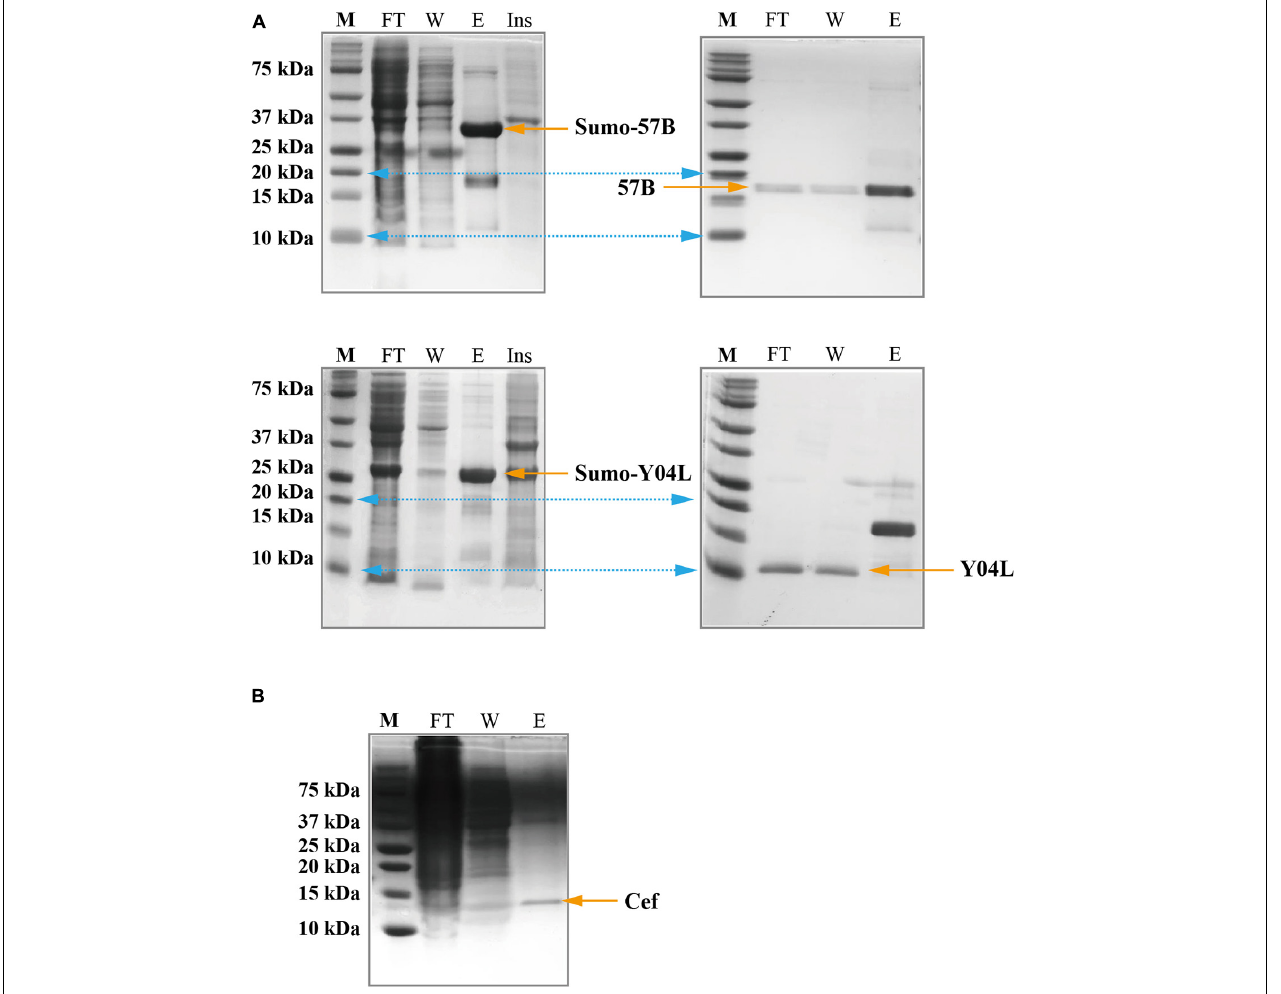
FIGURE 3 | SDS-PAGE showing the expression and the purification of viral proteins using solubilization tags and the cell-free expression system. (A) SUMO-Gp57B and SUMO-Y04L were expressed and collected in the soluble fraction, evident by the presence of bands of correct molecular weight in the elusion fraction (left). The native proteins were collected after SUMO cleavage, evident by the bands in the flow-through and wash fraction (right). M, Marker; FT, Flow-through fraction; W, Wash fraction; E, Elusion fraction; Ins, Resolublized cell debris containing insoluble protein. (B) Cef protein was expressed and collected in the soluble fraction, using the cell-free expression system, evident by the presence of a sharp band at the corresponding size in the elution fraction. M, Marker; FT, Flow-through fraction; W, Wash fraction; E, Elusion fraction.